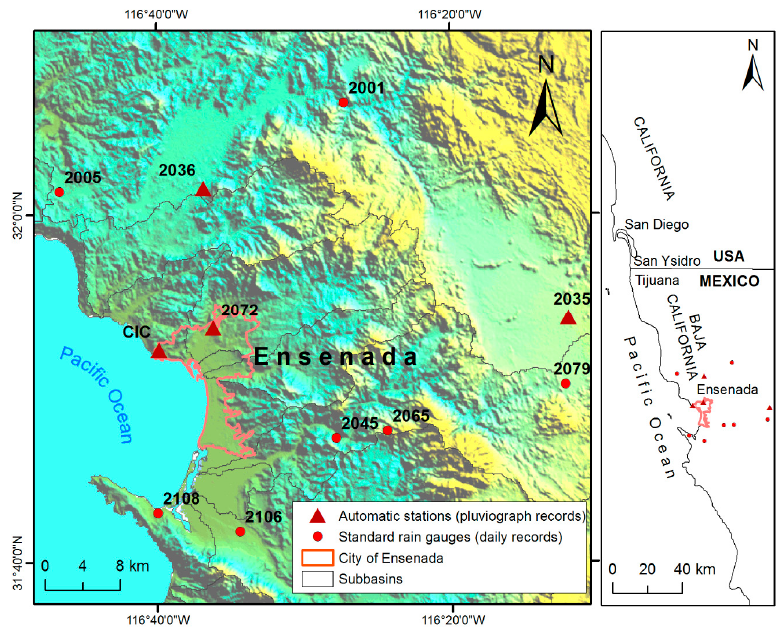
Figure 1. Study area location showing sub-basins and distribution of weather stations.